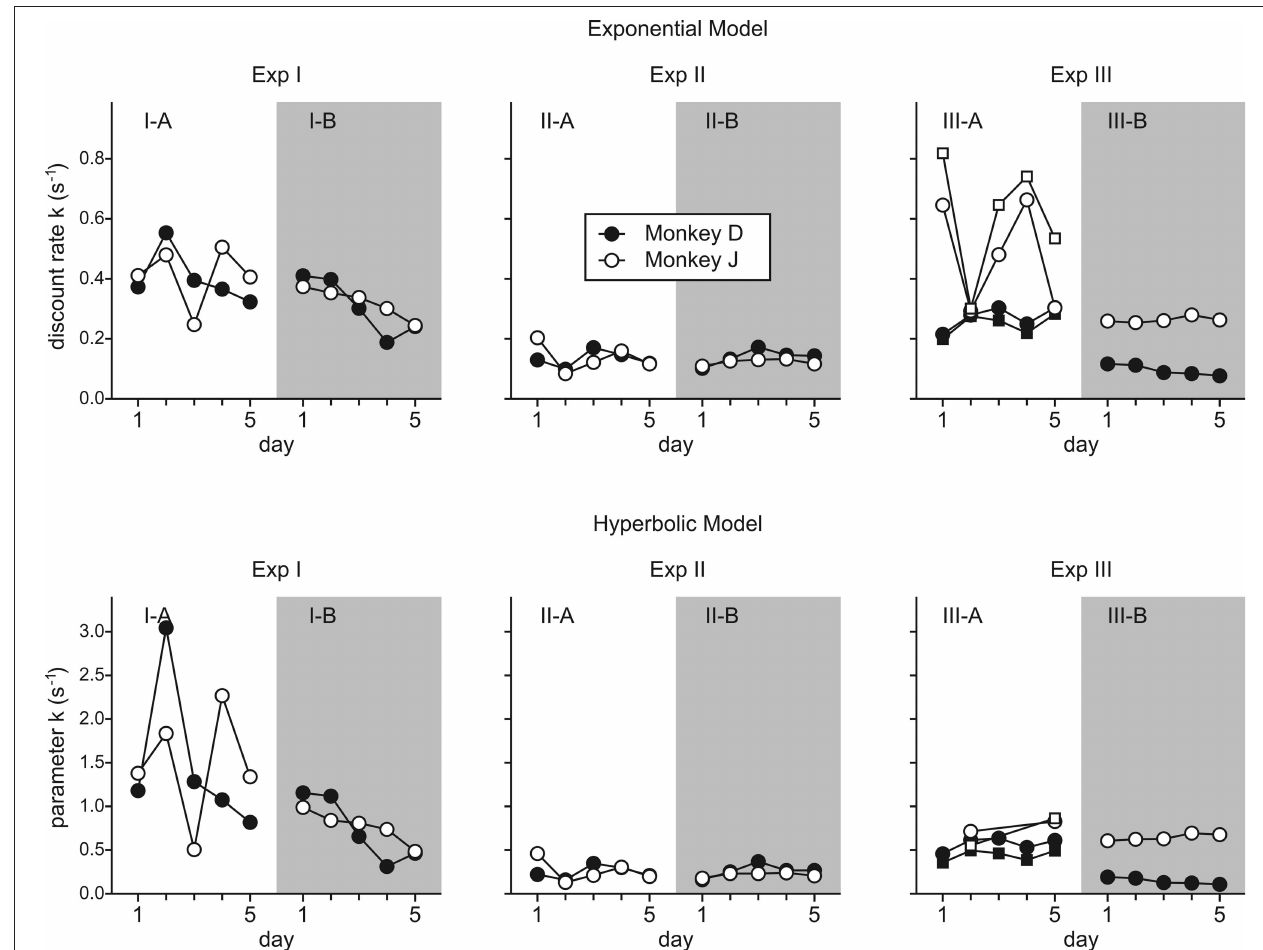
FIGURE 4 | Daily changes in the parameter k for the exponential (top) and hyperbolic (bottom) discount function. For Experiment III-A, squares indicate the values obtained from the trials in which the clocks did not include any cyan